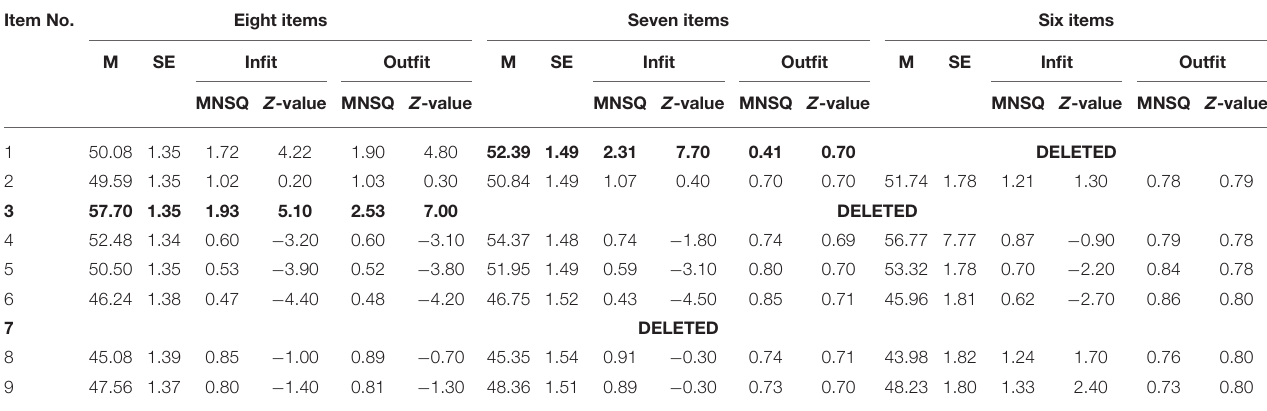
TABLE 3 | Item fit statistics according to entry order for eight, seven, and six items. Item No.